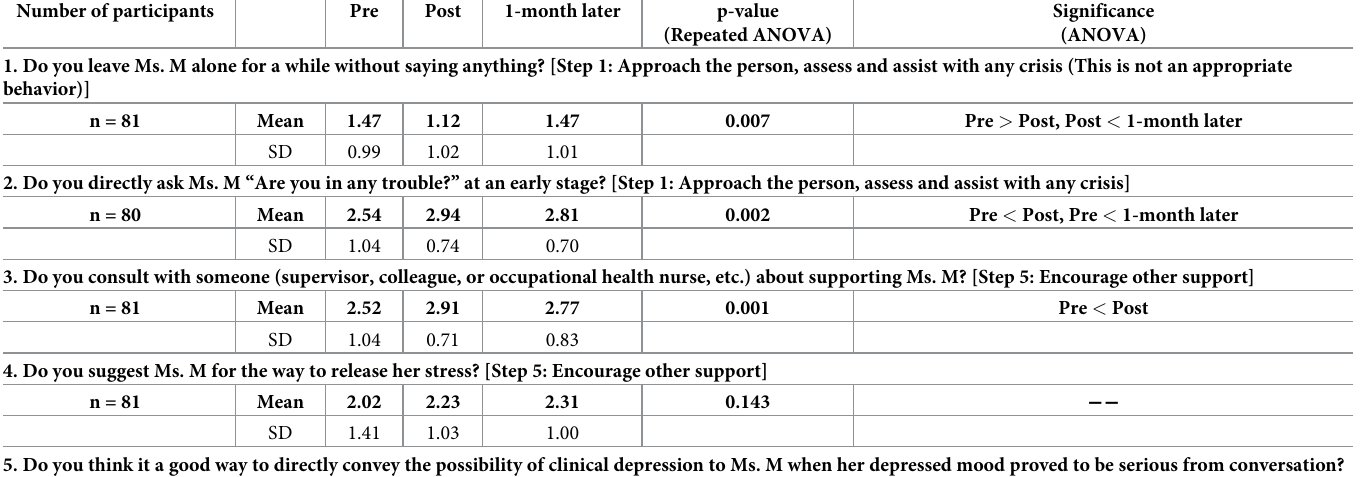
Significance (Repeated ANOVA) (ANOVA)